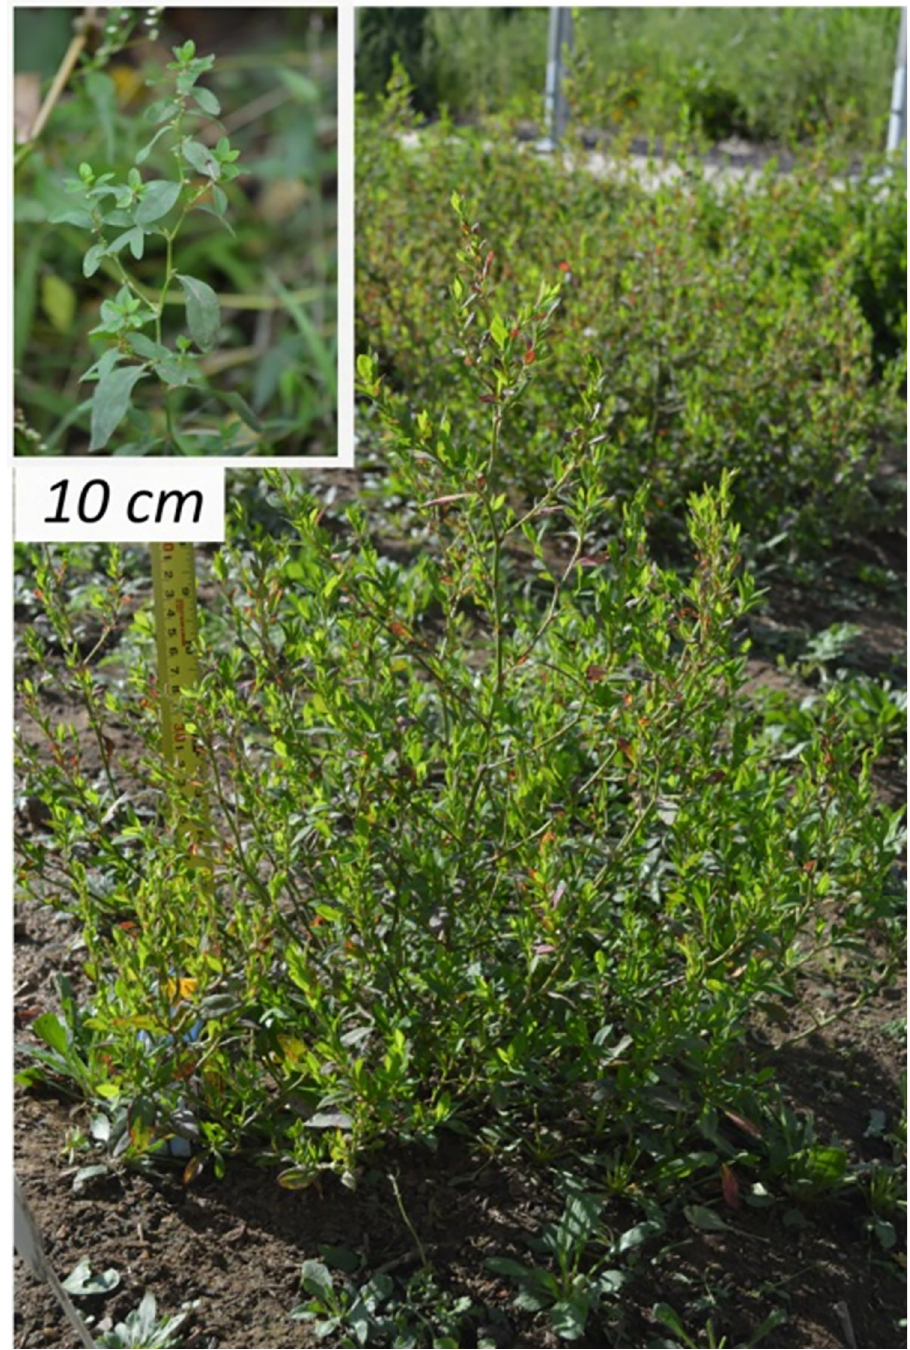
Fig 3. Examples of differences in plant size and architecture between typical individual free-living (inset) and experimental erect knotweed plants. Images are to scale.